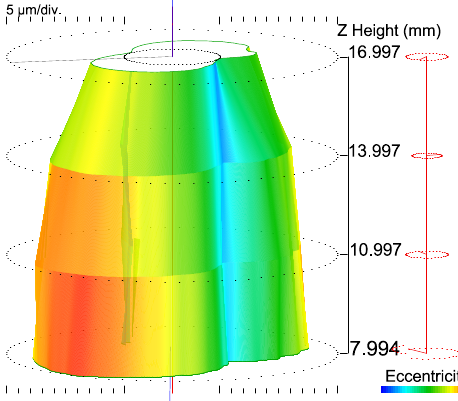
Figure 8. Cylindricity of the shank after